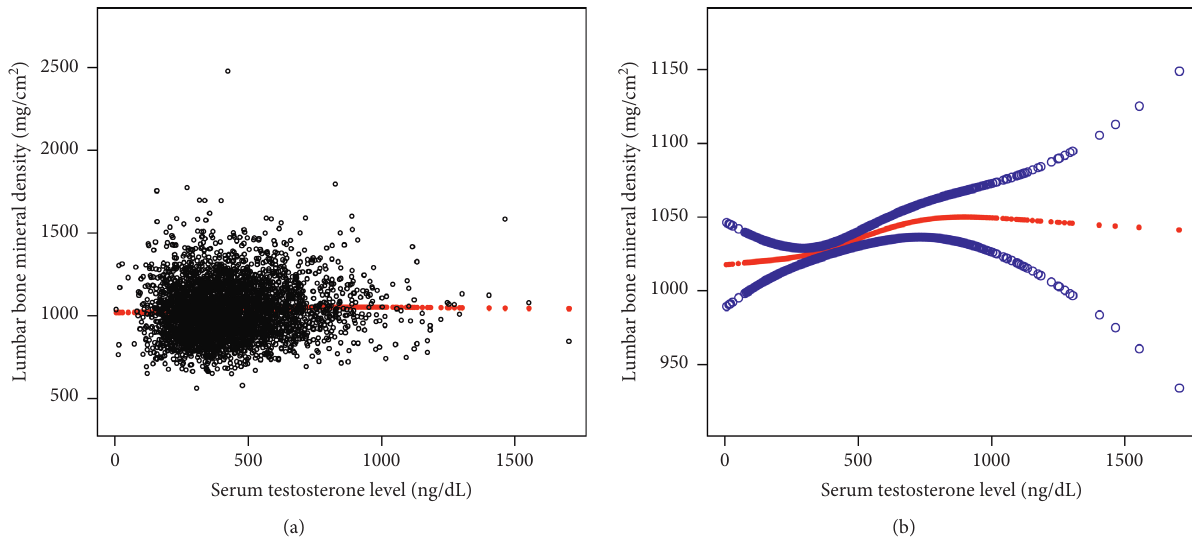
Figure 1: The association between serum testosterone levels and lumbar bone mineral density. (a) Each black point represents a sample. (b) Solid red line represents the smooth curve fit between variables. Blue bands represent the 95% confidence interval from the fit. Age, race, body mass index, education level, income-to-poverty ratio, smoking status, drinking behavior, moderate activities, calcium supplement use, blood urea nitrogen, serum uric acid, total protein, serum estradiol level, serum phosphorus, and serum calcium were adjusted.